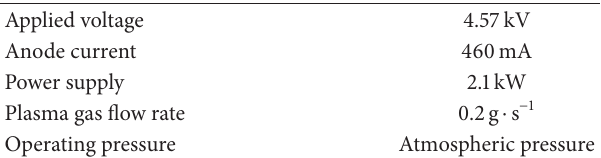
Figure 1: Experimental setup and photo of the plasma formed with a Titan-like atmosphere. Table 1: Nominal operating conditions of the plasma torch